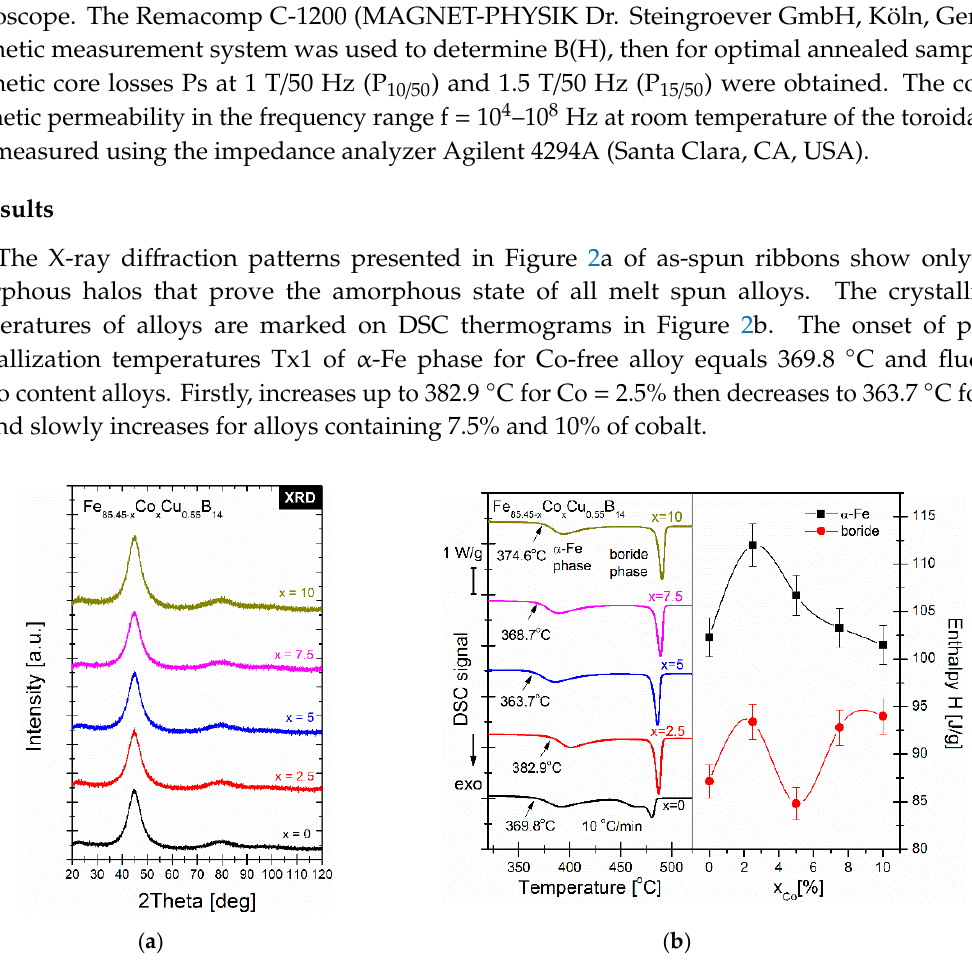
Figure 2. XRD patterns ( a ) and DSC signals together with enthalpy from Co content dependence ( b ) for as-spun metallic glasses.